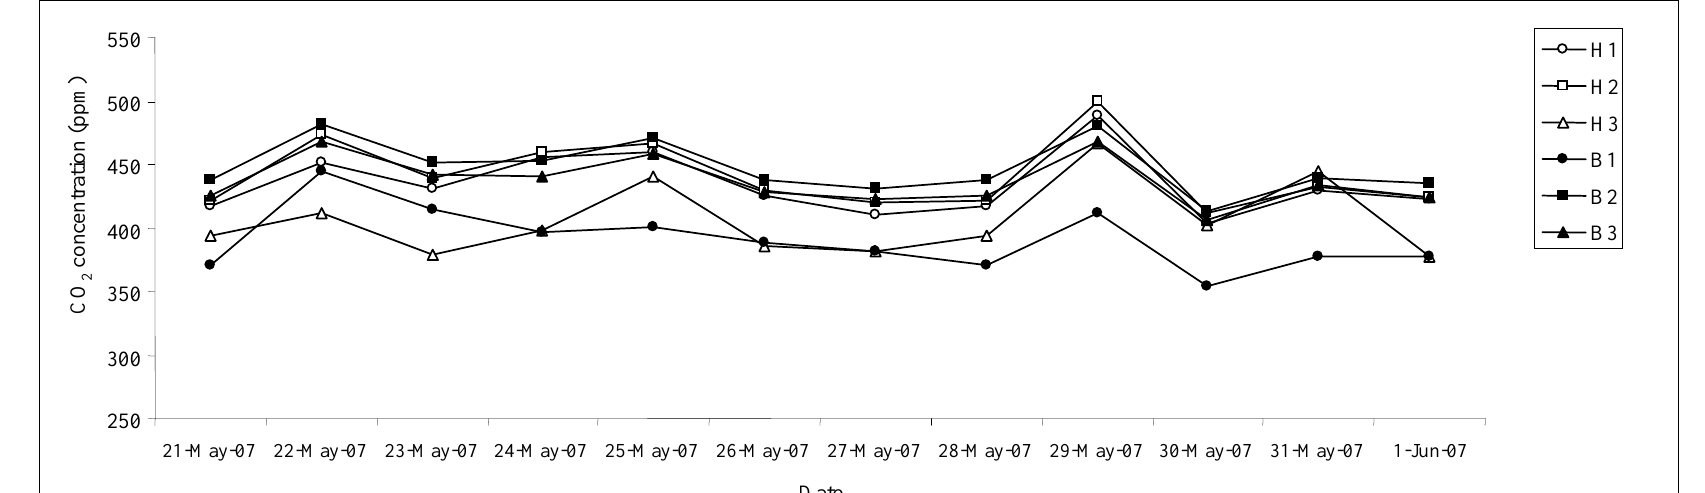
Figure 3b. The variation patterns in the mean CO compared in terms of the daily mean